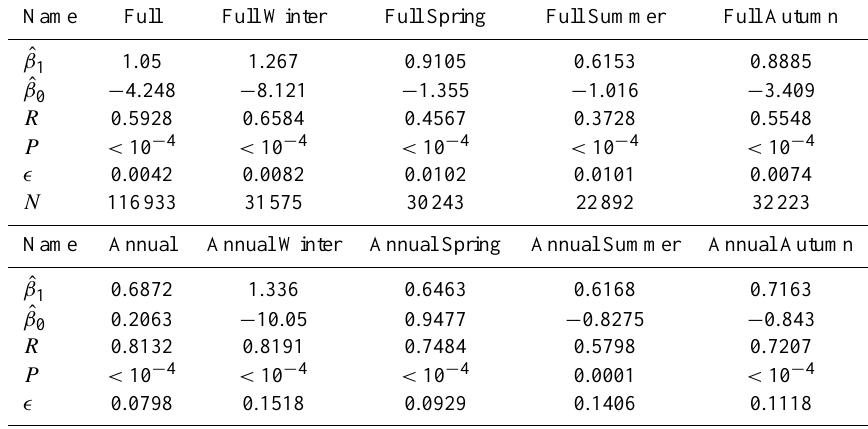
Table 3. Linear regression output parameters for nitrates.